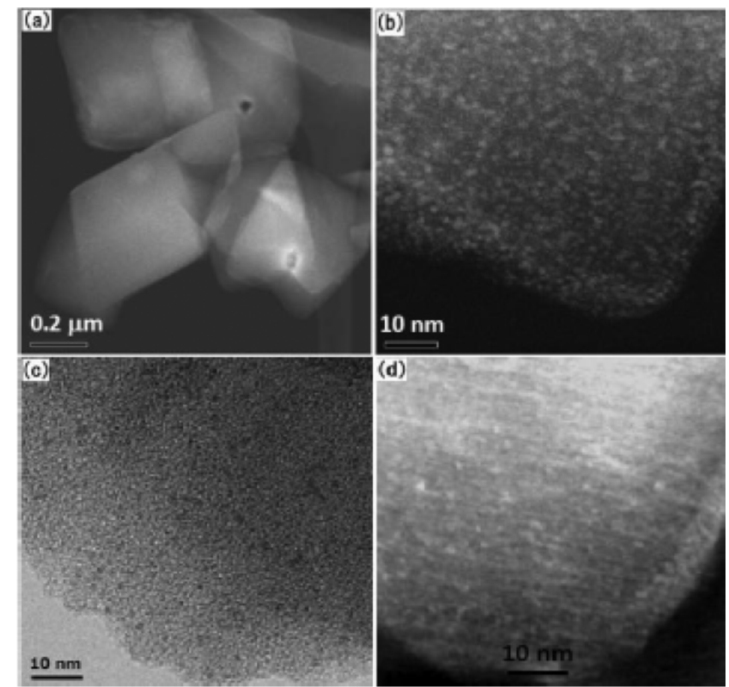
Figure 3. ( a , b ) HAADF-STEM; ( c ) TEM images; and ( d ) reconstructed slice by tomography of 2 wt. % Pt@MIL-101. Reproduced with permission of Ref. [46]. Copyright